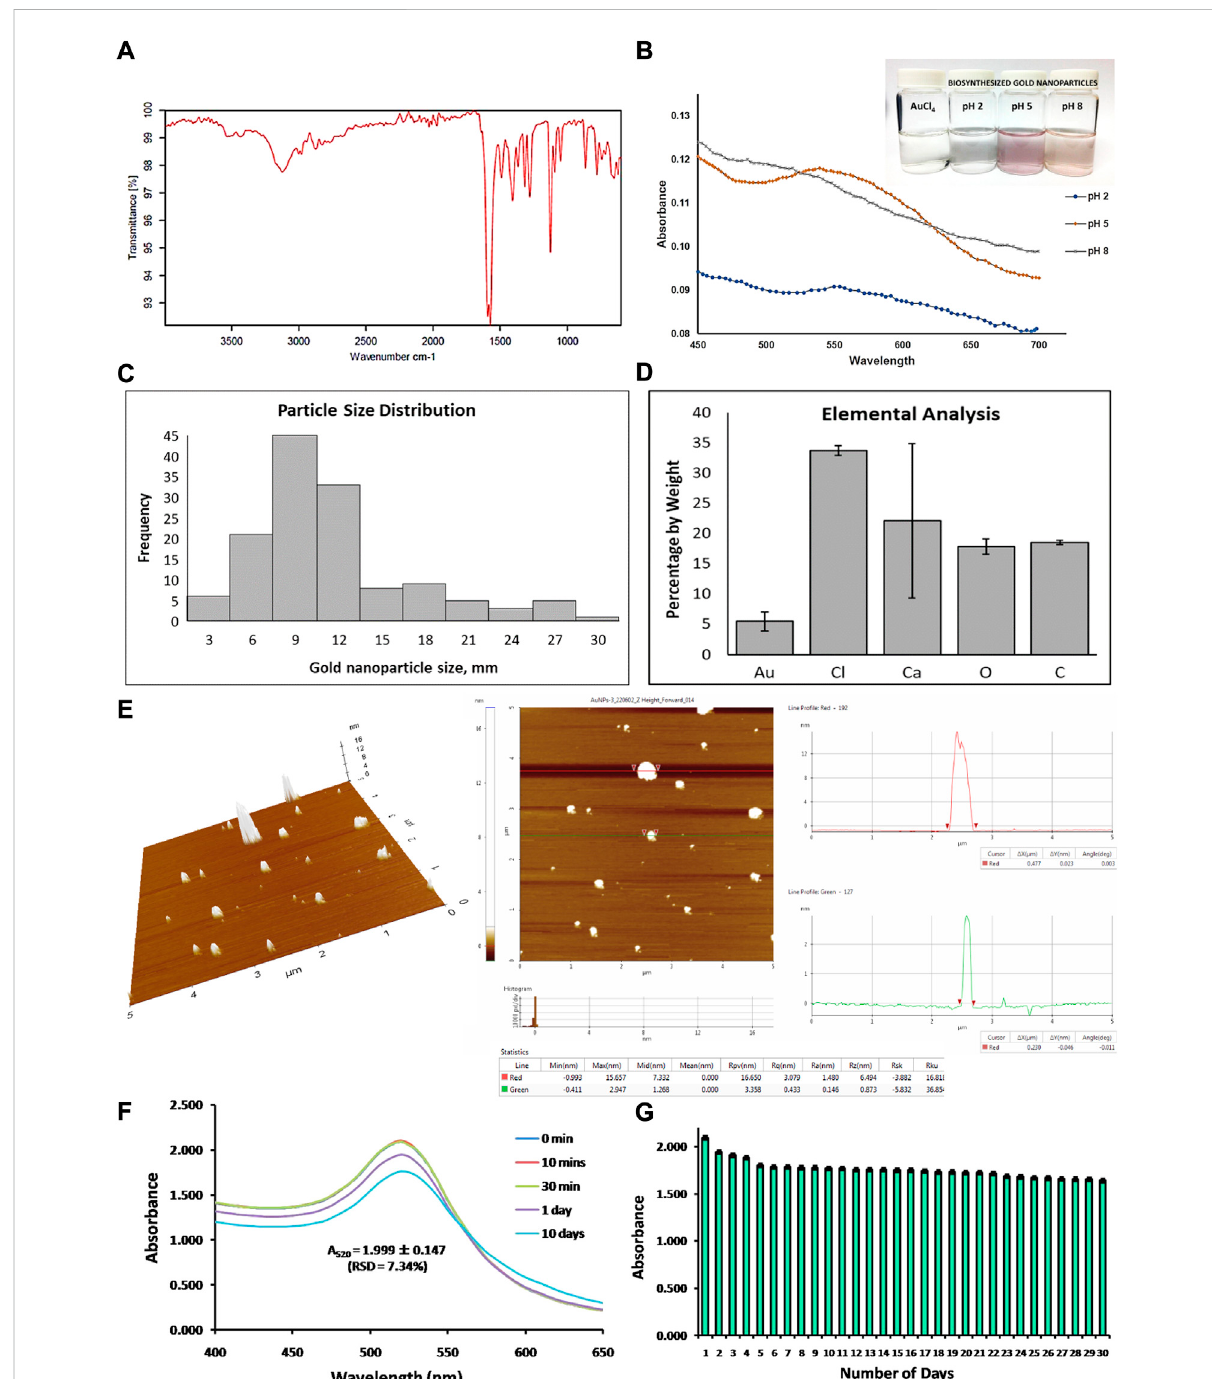
Characterization of biosynthesized gold nanoparticles from the reduction of chloroauric acid by lactic acid. (A) Characterization of lactic acid isolated from Lactobacillus acidophilus through its infrared spectra. (B) Analysis of absorbance data, wavelength spectrum, and visual appearance of biosynthesizedgoldnanoparticlesatdifferentpHconditions(pH2,pH5,andpH8). (C) Particlesizedistributiondeterminationintermsofnanometer (nm) scale, (D) elemental analysisof thesamplein termsof percentageby weight of gold, chlorine, calcium, oxygen, and carbon detection,and (E) atomic force microscopic data analysis showing three-dimensional AFM images and line pro fi le analysis of biosynthesized gold nanoparticles. Last, the stability of biosynthesized gold nanoparticles was analyzed (F) after 10 days of storage and (G) after 30 days of